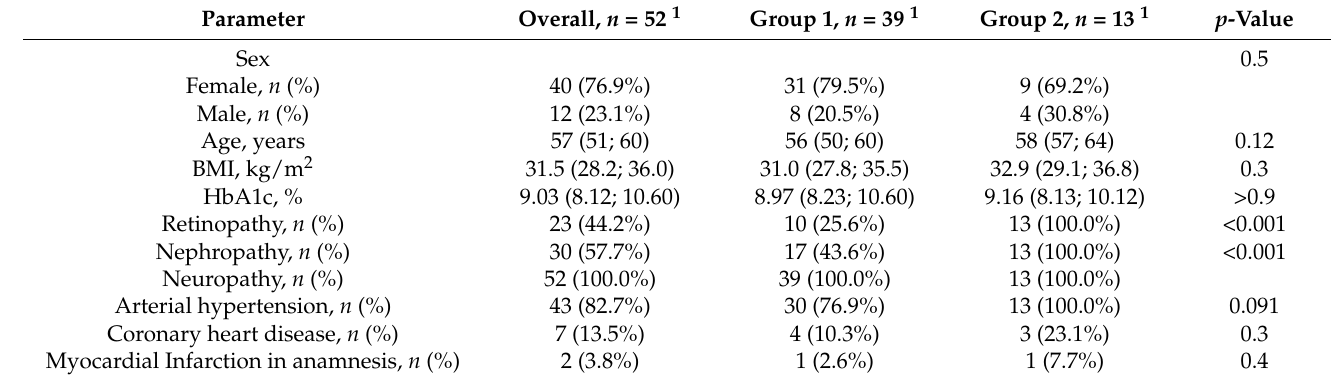
Table 1. The characteristics of the patients. Me (LQ; UQ) are calculated for quantitative variables.